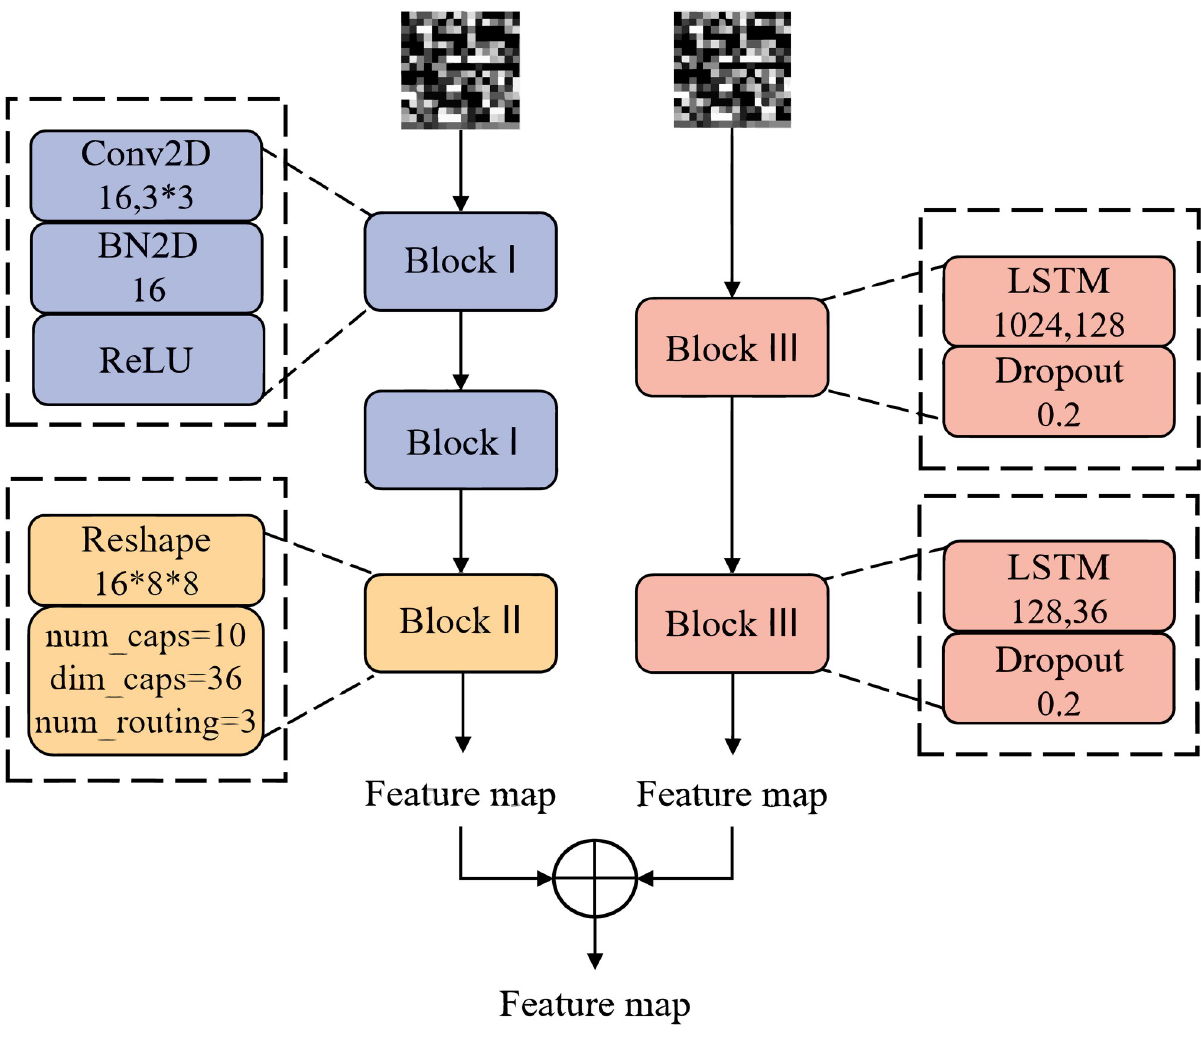
Fig 5. Temporal-spatial feature fusion model using